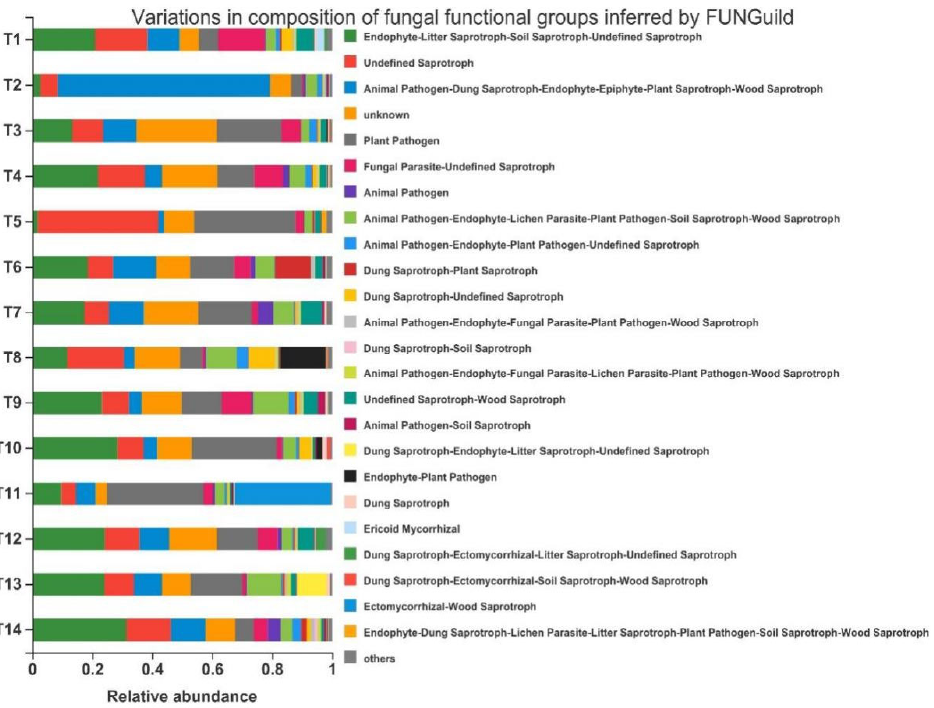
Figure 7. Relative abundance of FUN Guild functional groups of soil fungal communities in different aged apple orchards. T1: Gao Bao Village; T2: Lu Bai Village; T3: Bei An Shan Village; T4: Lunar Eclipse Village; T5: Bei Gu Village; T6: Yang Wu Village; T7: Bed Guang Rong Village; T8: Bai Jia Zui Village; T9: Northwest Ding Village; T10: Shang Cao Di Village; T11: Shang Huang Zhang Village; T12: Gu Xian Village; T13: Jing Yao Ke Village; T14: A Si Village.